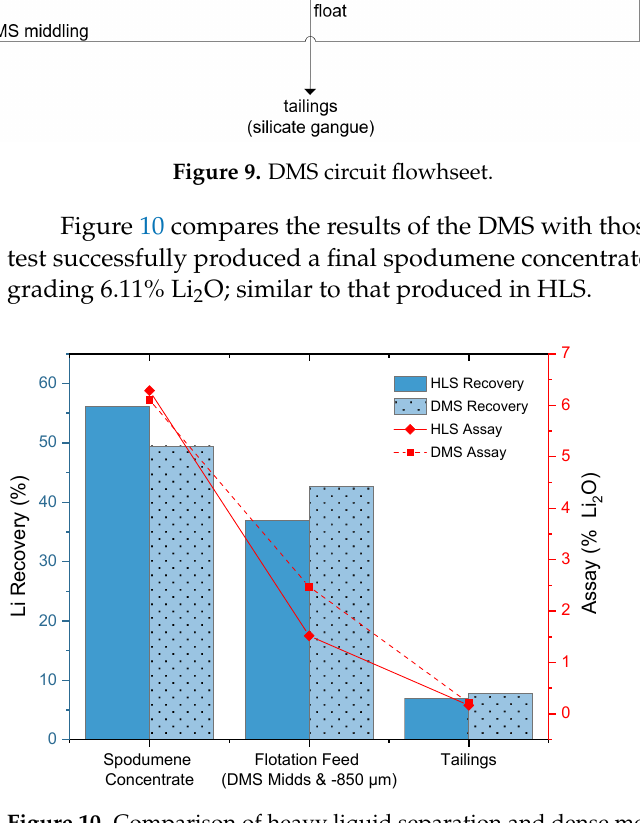
Figure 10. Comparison of heavy liquid separation and dense media separation results.